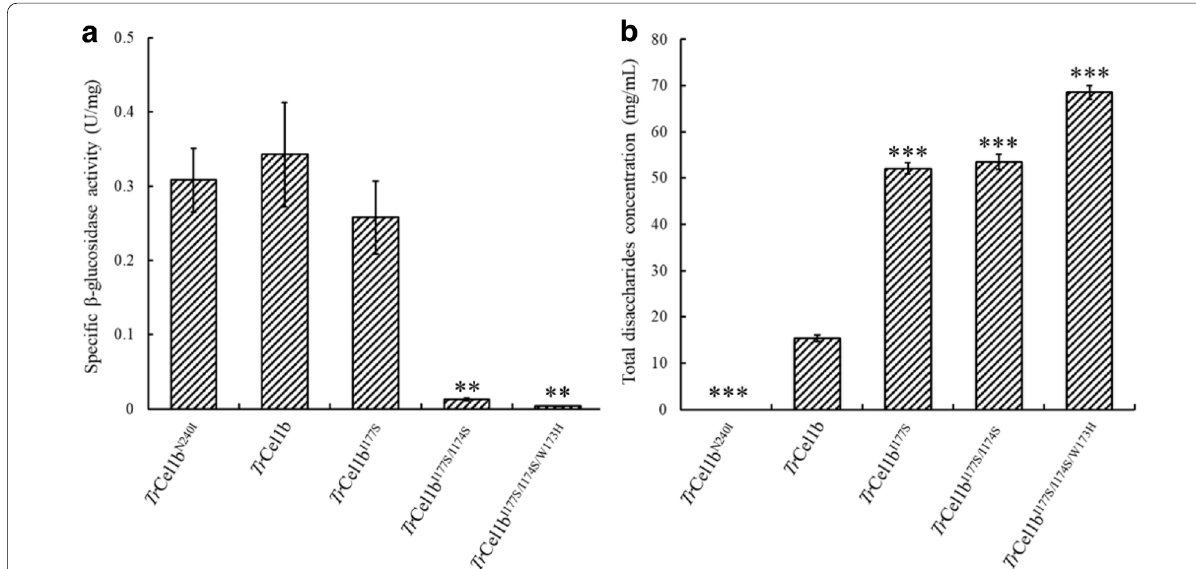
Fig. 3 The specific β -glucosidase activity ( a ) of Tr Cel1b and its variants and the total disaccharides production ( b ) synthesized by Tr Cel1b and its variants using 80% (w/v) glucose as the substrate for 72 h at 30 °C. Total disaccharides concentration represents the sum of the production of laminaribiose, sophorose and cellobiose synthesized by Tr Cel1b and its variants. * p < 0.05; ** p < 0.01; *** p < 0.001. The statistically significant difference was performed between Tr Cel1b and its